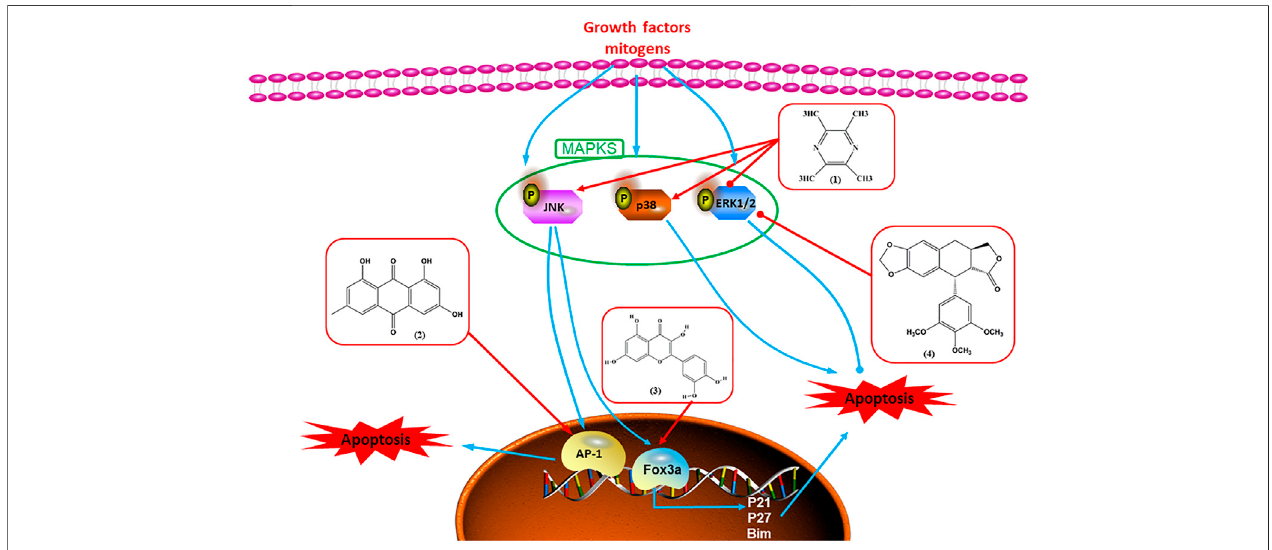
FIGURE 4 | Natural products induced apoptosis through MAPK pathway. (1) Tetramethylpyrazine, (2) emodin, (3) quercetin, (4) Deoxypodophyllotoxin.